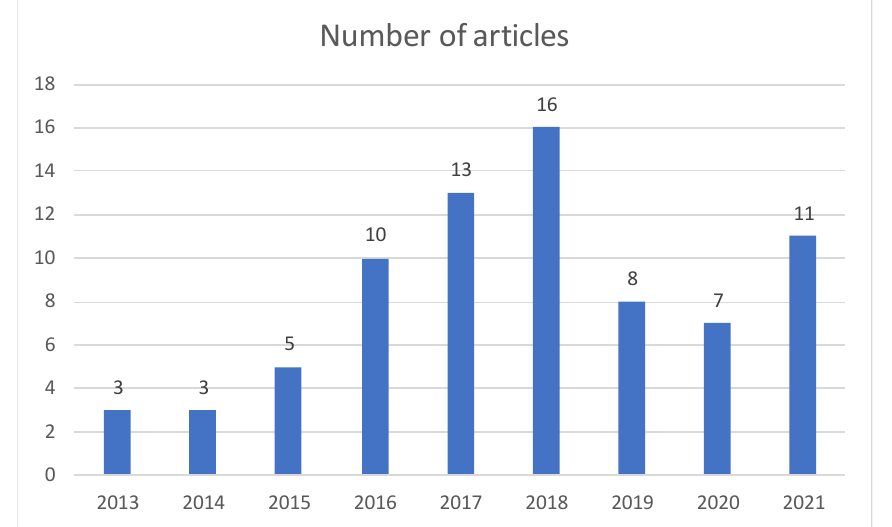
Figure 2. Distribution of the articles by publishing year.